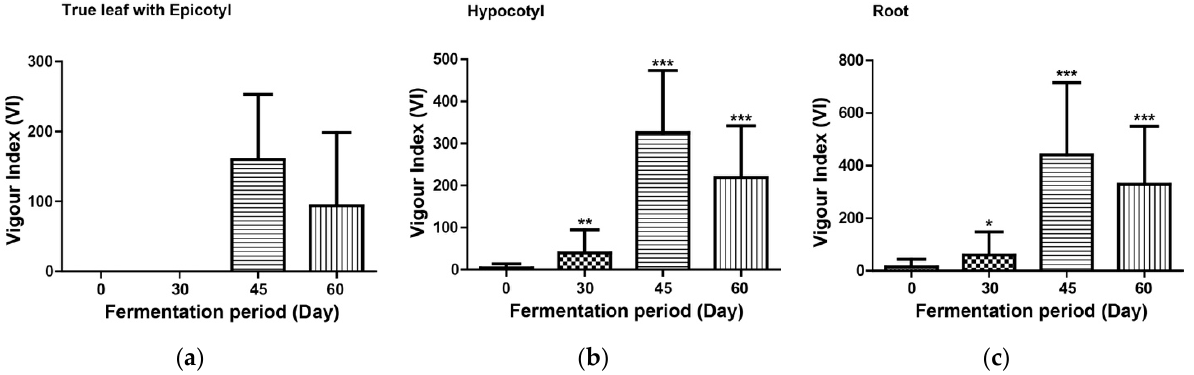
Figure 4. Effect of the fermentation period [unfermented sawdust (0), 30-day fermented sawdust (30), 45-day fermented oak tree sawdust (45), and 60-day fermented oak tree sawdust (60)] on vigor index (VI). ( a ): True leaf with epicotyl; ( b ): Hypocotyl; ( c ): Root. Each fermentation period was statistically compared with 0 day. The asterisks indicate significant difference (* p < 0.05, ** p < 0.01, and *** p < 0.001).